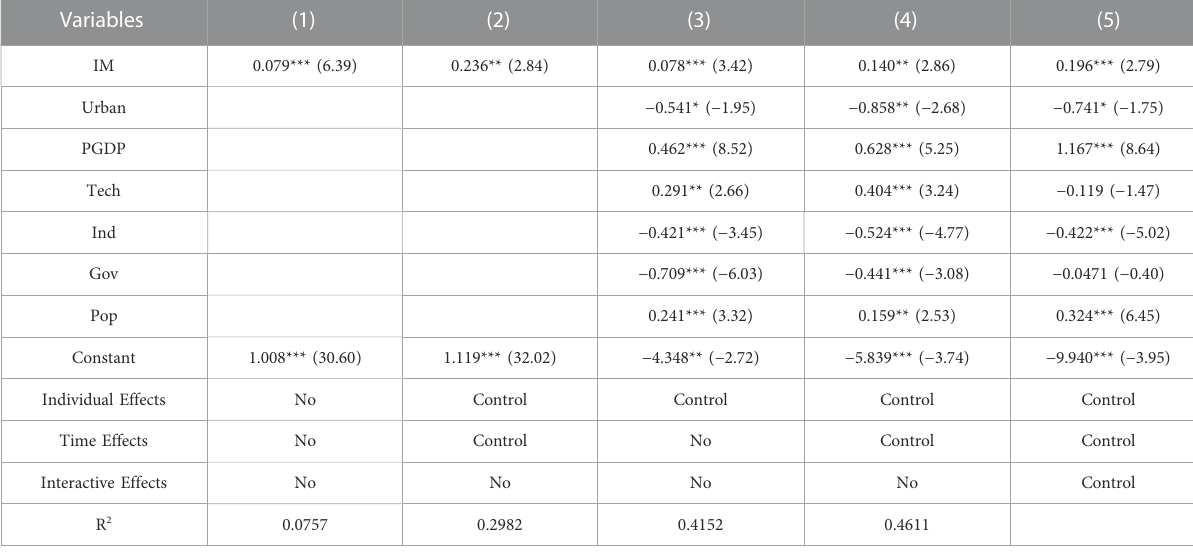
TABLE 2 Impact of IM on GTFP:Baseline regression